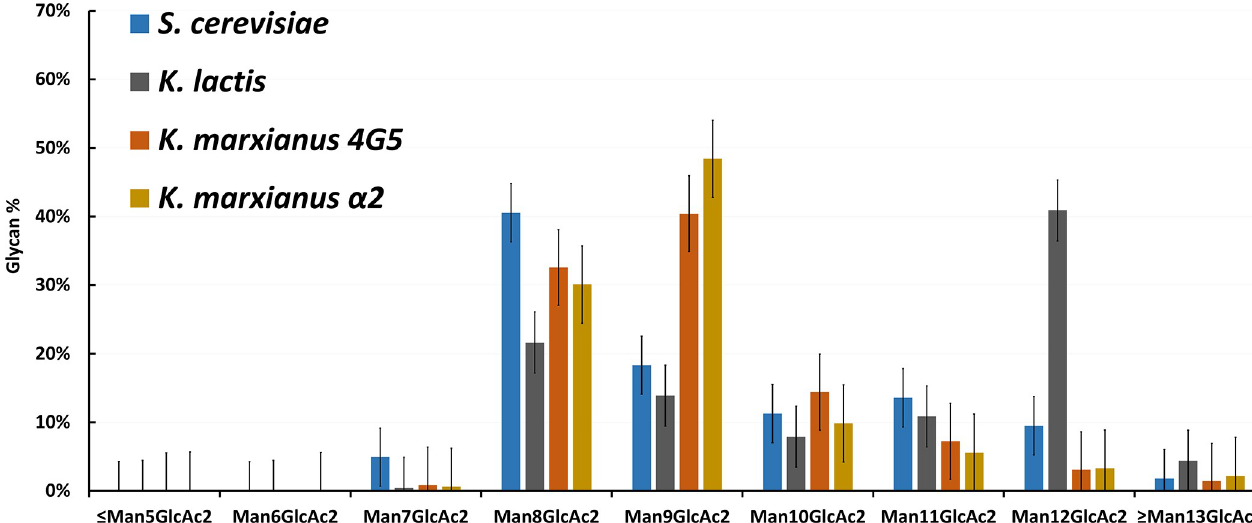
Fig 1. Analysis of N-glycans in S . cerevisiae , K . lactis , and K . marxianus 4G5 and K . marxianus α 2.